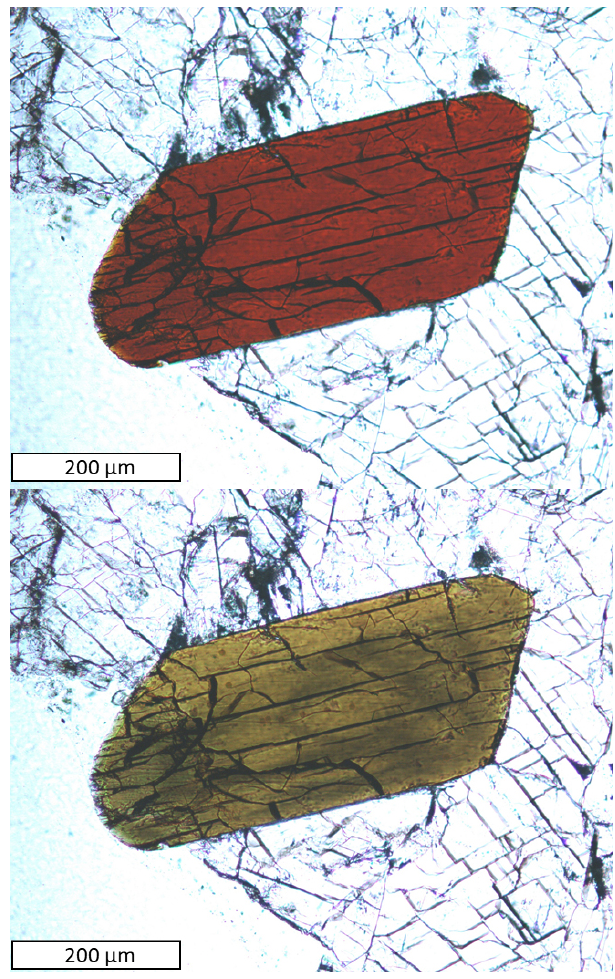
Figure 3. A zinkgruvanite crystal with baryte, barytocalcite and witherite. Thin section (30µm), in transmitted polarized light, showing maximum pleochroism colours for 90 ◦ orientations.